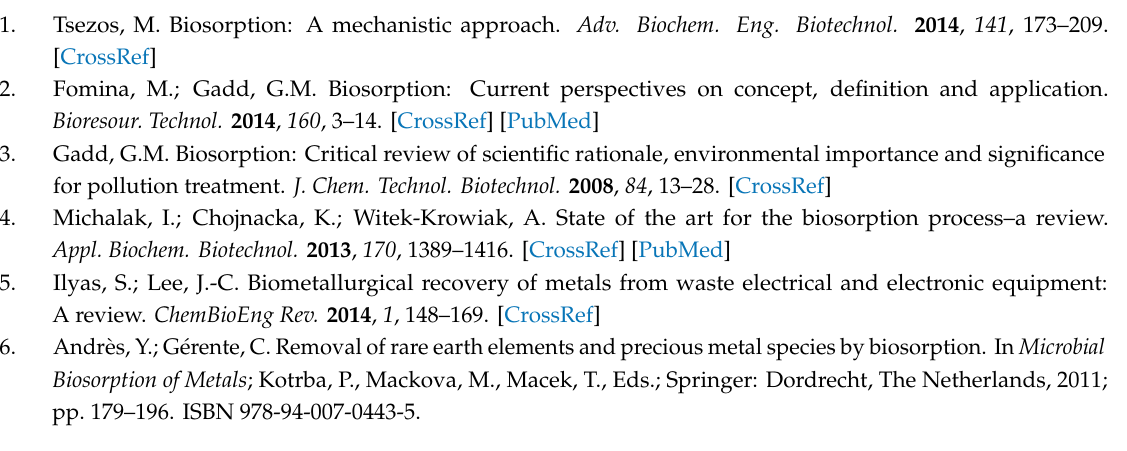
Table S1: Comparison of the relative biosorption of four REEs by B. subtilis with the relative biosorption of eight REEs by B. subtilis at pH 2.5. Figure S1: Relative biosorption and amount of REE uptake by B. subtilis . Figure S2: Relative biosorption by L. methylohalidivorans and P. inhibens at di ff erent amounts of biomass. Figure S3: REE biosorption by Pichia sp. at two di ff erent amounts of biomass. Figure S4: Relative biosorption by B. subtilis immobilized in 1.5% and 2% agarose. Figure S5: Relative biosorption by C. chromoblastomyces